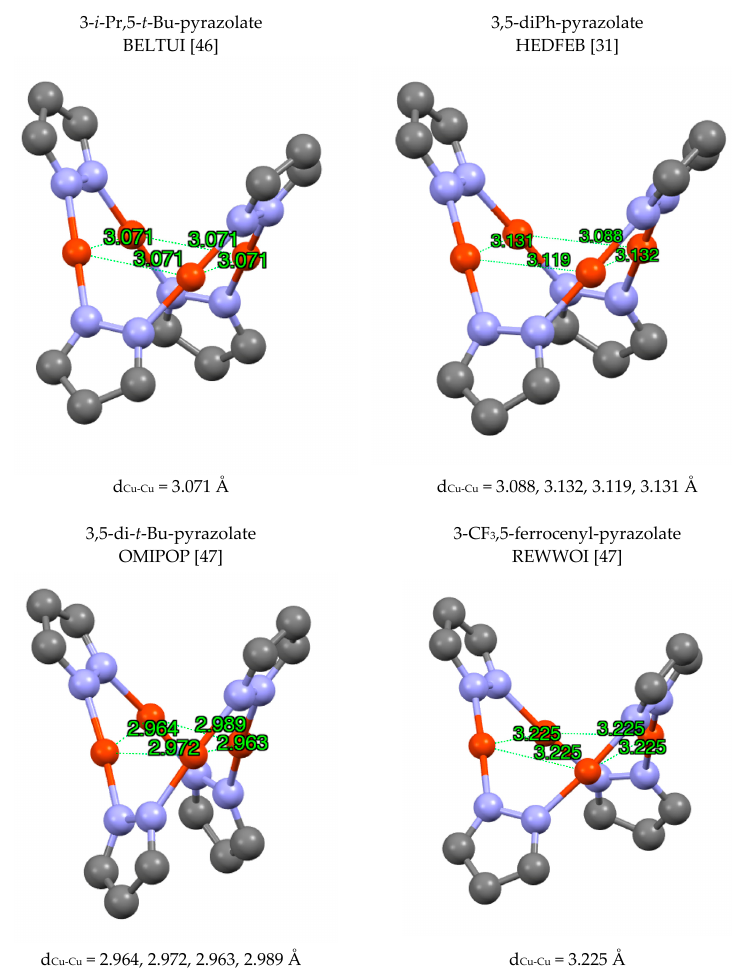
Figure 5. Different modes of (pzCu) 4 complexes. Only the copper atoms and the pyrazolate rings are represented. The sequential Cu-Cu distances are listed.